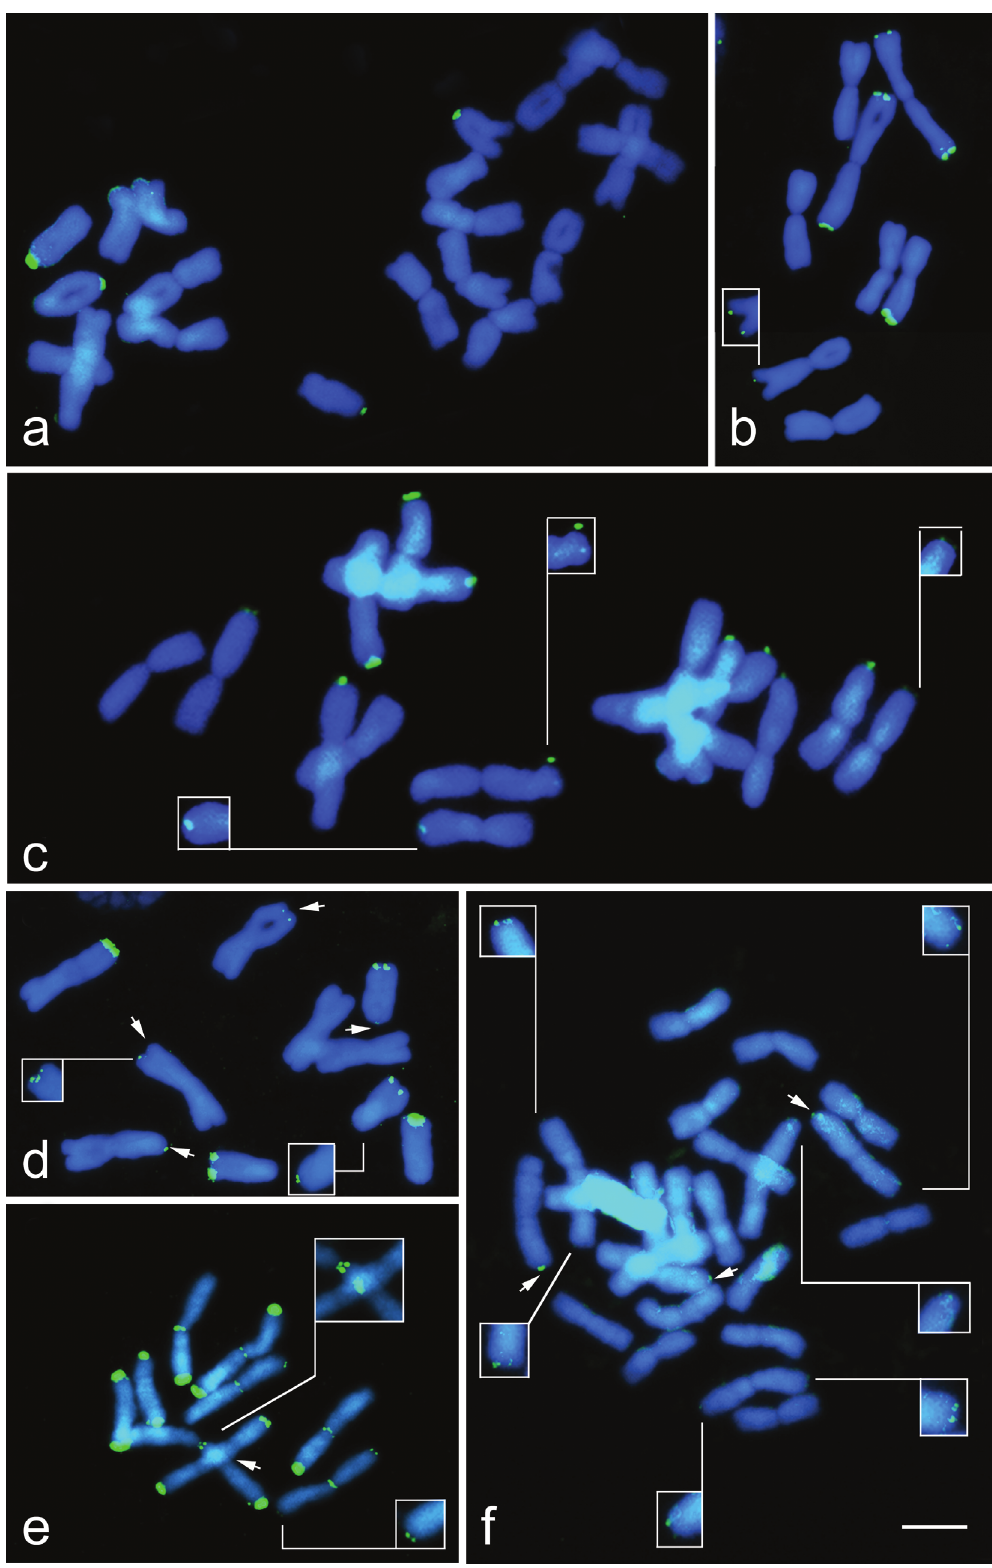
Figure2 -Distributionof35SrDNAsites(green)in Nothoscordumpulchellum 2 n =20(a); N.gaudichaudianum 2 n =8(b); N.gaudichaudianum 2 n =16 (c); N.felipponei 2 n =10(d); N.marchesii 2 n =10(e); N.izaguirreae 2 n =24(f).ObserveincanassociationbetweenrDNAsitesintwoacrocentricchro- mosomes, with one of them smaller than the other. Arrows indicate small rDNA sites and insets show the sites that were not visible after merging DAPI (blue) and FITC (green) images. The scale bar corresponds to 10 (cid:2)